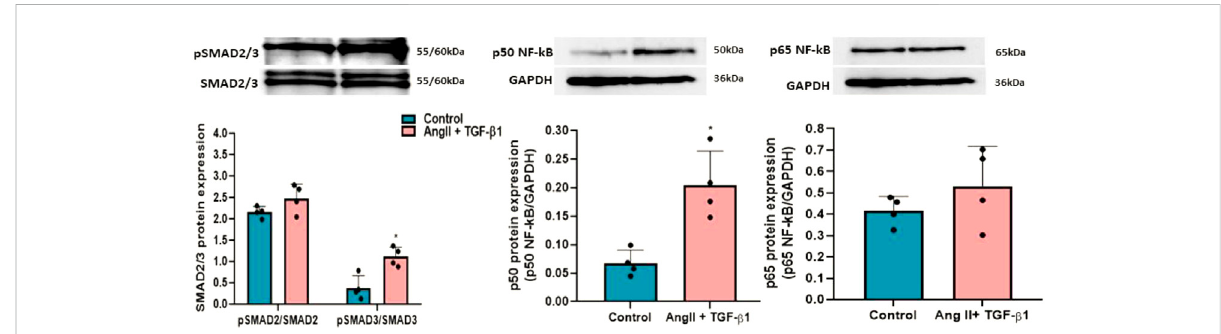
FIGURE 2 Western blot analysis for relative expression of pSMAD2/3 and p50/p65NF-kB molecules with role in hypertrophic growth of hiPSC-derived cardiomyocytes in culture. Histograms show a quantitative representation of the protein levels of pSMAD2/3 and p50/p65NF-kB obtained from hiPSC-CMs stimulatedwithAngII+TGF- β 1for48 hoursandfromunstimulatedhiPSC-CMs takenascontrolcells. Eachvaluerepresentsthemean± SD. The statistical signi fi cance, noticeably different, was represented as * p < 0.05 values versus control cells ( n = 4). Statistical analysis was conducted usingT-test. Thegrey intensity ofrelated proteinswas analysed byTotalLabTL120program. The housekeeping β -actin proteinwas used as an internal control for protein normalization and monitor for equal